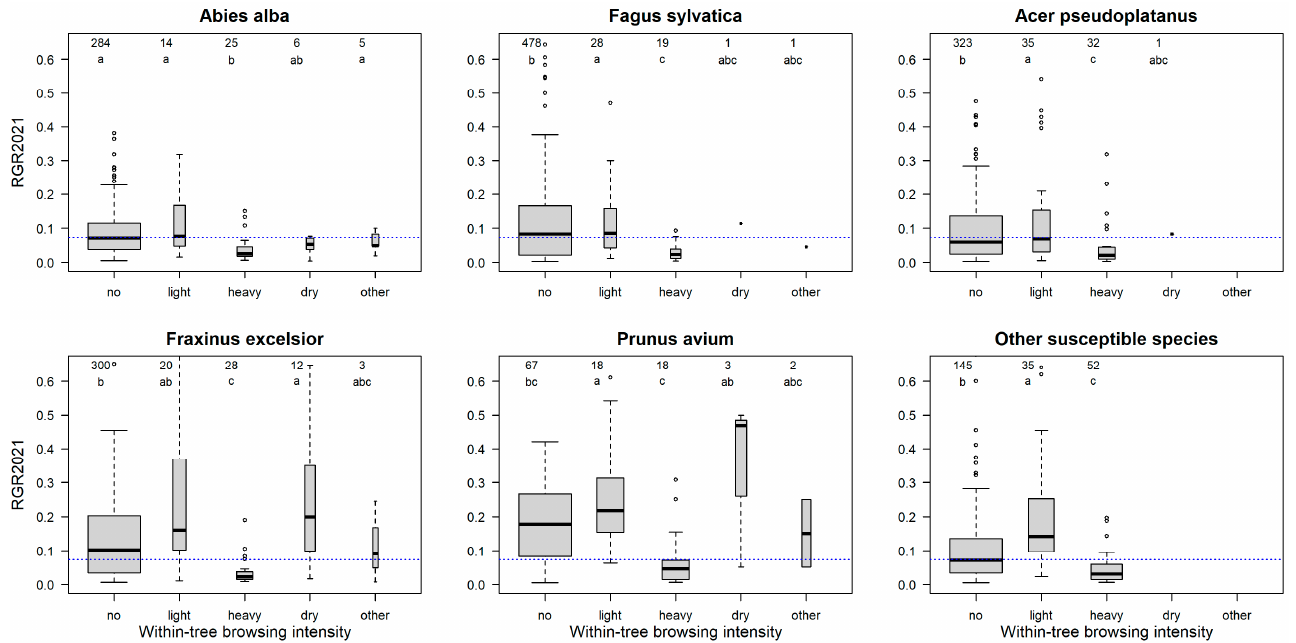
Figure 4. Relative growth rate in 2021 (RGR2021) per within-tree browsing intensity category in winter 2021/2022. Saplings from HC1 to HC4 are included. The blue dotted line represents the me- dian growth rate over all tree species. The numbers given in all panels indicate the number of sap- lings sampled in the respective categories for that species. Different lower-case letters indicate sig- nificant differences at p ≤ 0.05 between the within-tree browsing intensity in post-hoc tests (for cases